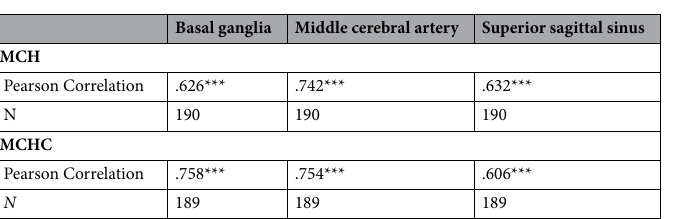
Table 2. The correlation matrix of CT values from basal ganglia, middle cerebral artery, and superior sagittal sinus, and the MCH and MCHC values from the blood test. (* p < 0.05, ** p < 0.01, and *** p <